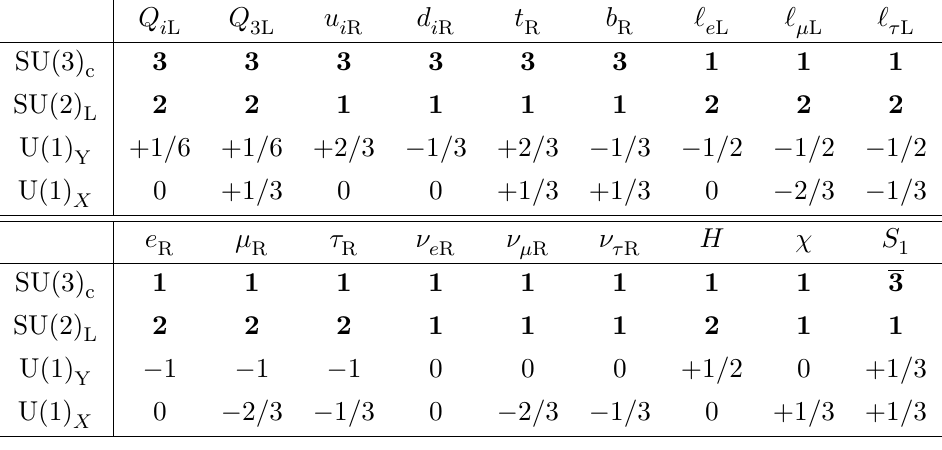
(for α = e, µ, τ ), α R ⊗ SU(2) ⊗ U(1) ⊗ U(1) gauge symmetry, c X L Y , u , d } represent the first two generations of quarks, and H i L i R i R